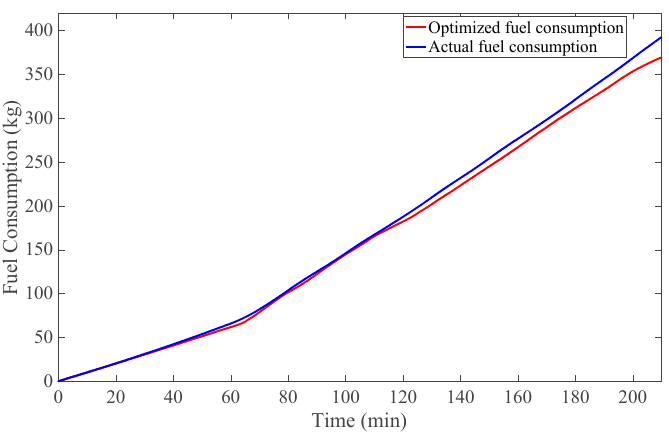
Figure 17. Total fuel consumption of the ship.